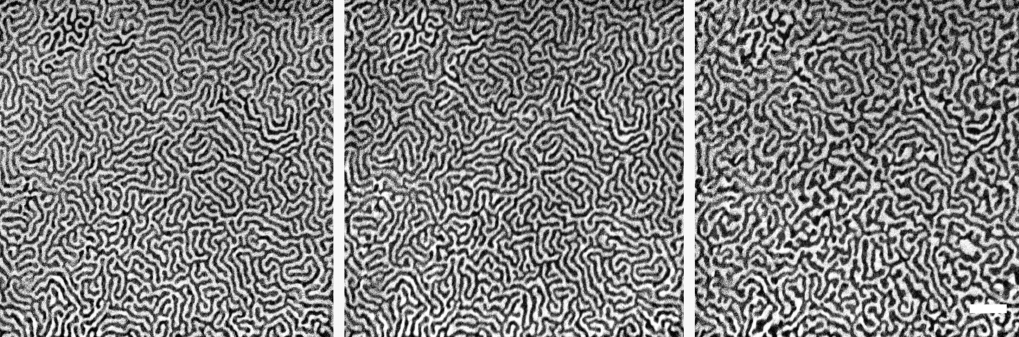
Figure 12 Magnetic domain patterns from XMCD measurements in a Pt /Co multilayer sample with an out-of-plane magnetic moment. Images were taken at the remanent state after applying out-of-plane magnetic fields of 0 mT (left), 25 mT (middle) and 72 mT (right). The images were taken with a photon energy of 780 eV ( L 3 peak in the Co XAS spectrum) and a kinetic energy of 1.6 eV. The undulator phase +( (cid:3) )16 mm is used for the right (left) circular polarization. The scale bar is 1 m m.